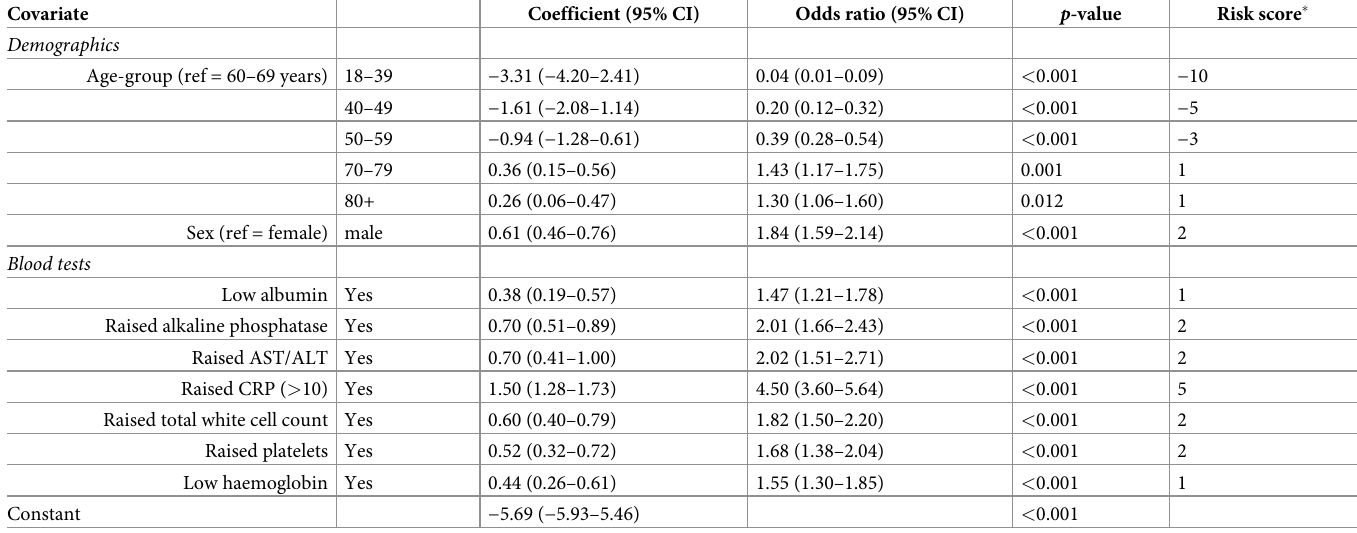
Table 4. Tm—Tests-only